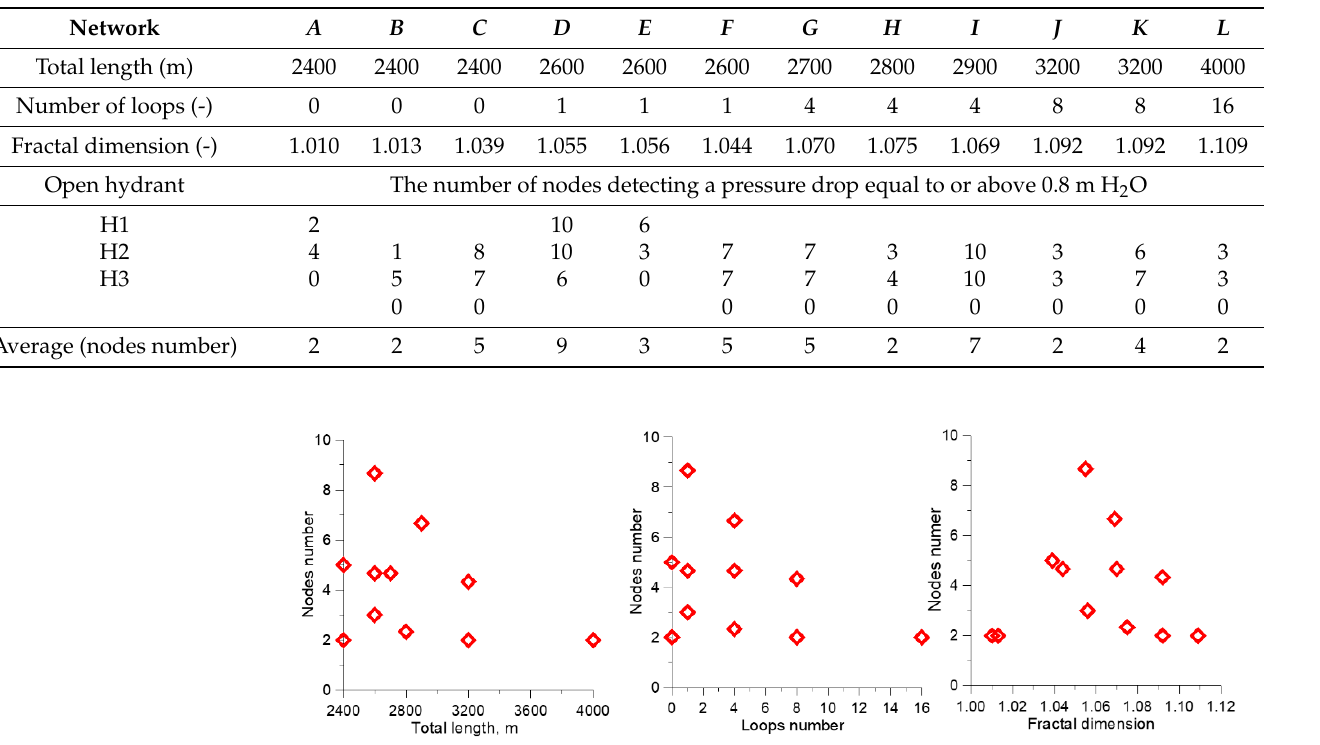
Figure 8. The average number of nodes detecting a pressure drop equal to or above 0.8 m H 2 O depending on total pipe length, number of loops, and fractal dimension of the analysed networks.